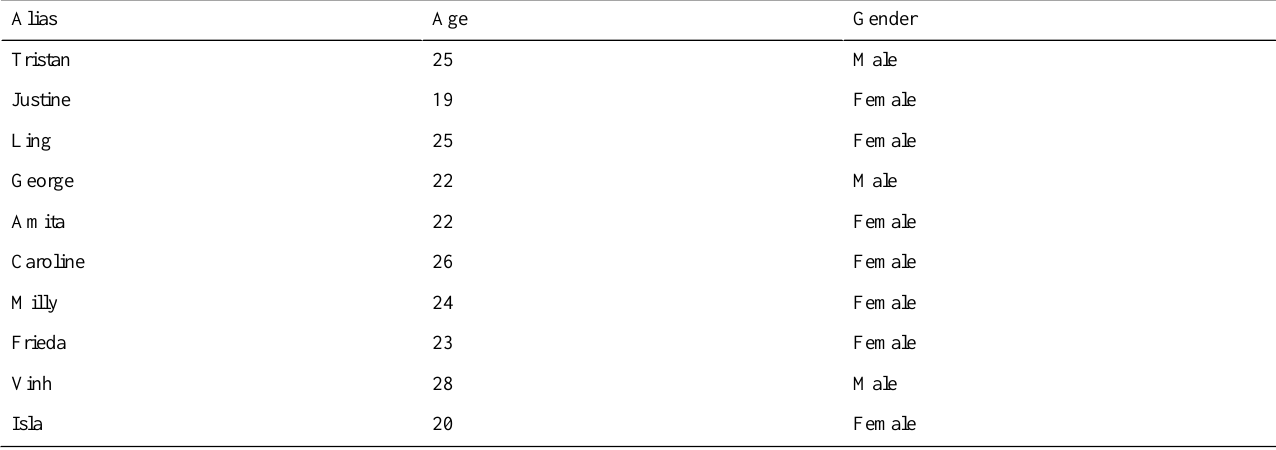
Table 1. Alias, age, and gender of participants.